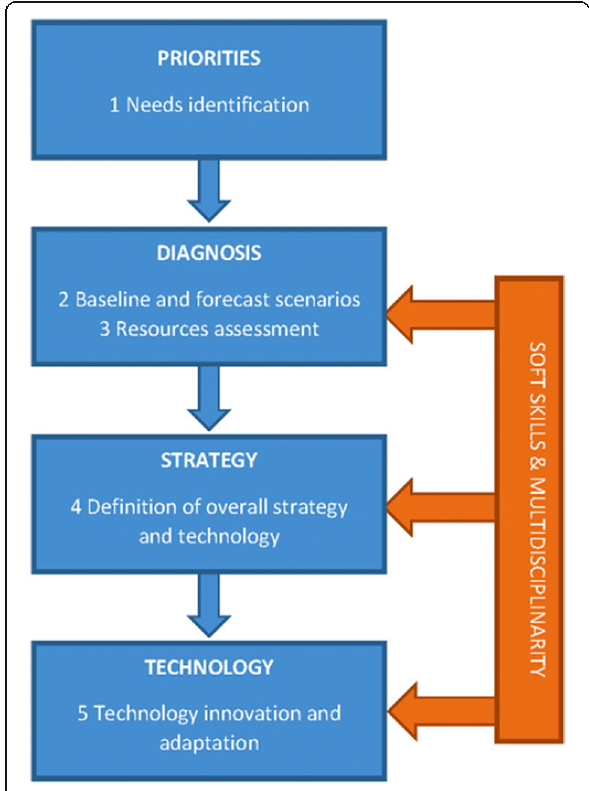
Fig. 1 The proposed methodology for technology transfer and